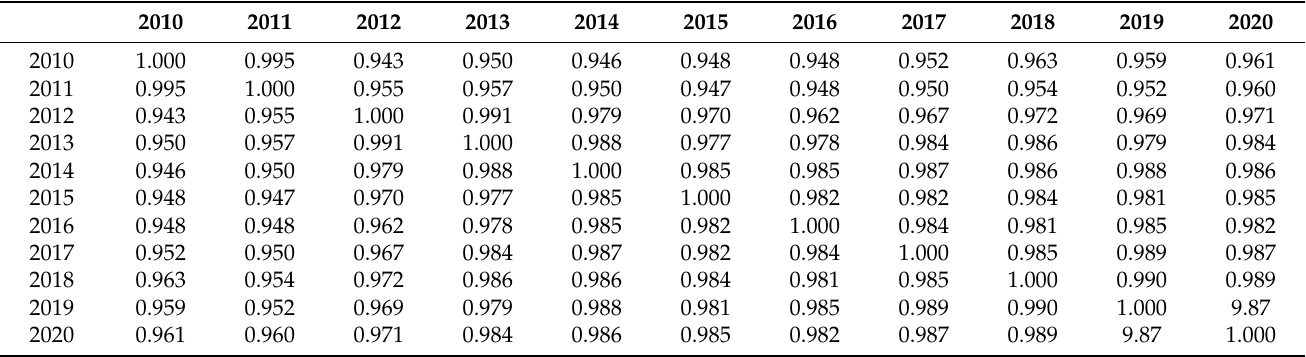
Table 5. Spearman rank correlations for the ranking of the EU-28 countries according to EI.